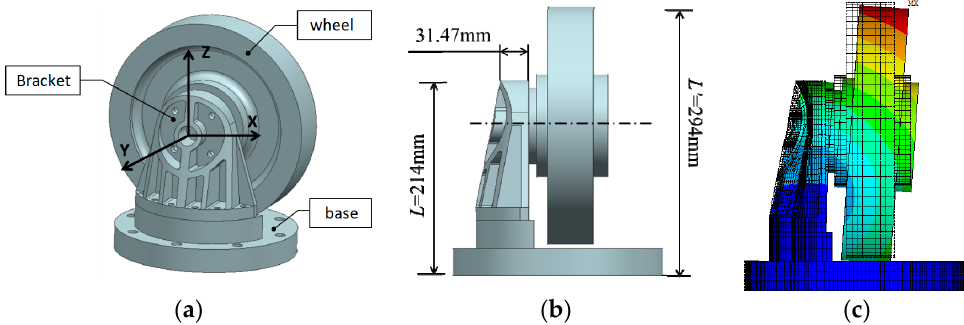
Figure 2. Test structure ( a ) coordinate definition and component name; ( b ) structure size; ( c ) Figure2. Teststructure( a )coordinatedefinitionandcomponentname; ( b )structuresize; ( c )fundamental fundamental mode shape of the primary system. mode shape of the primary system.